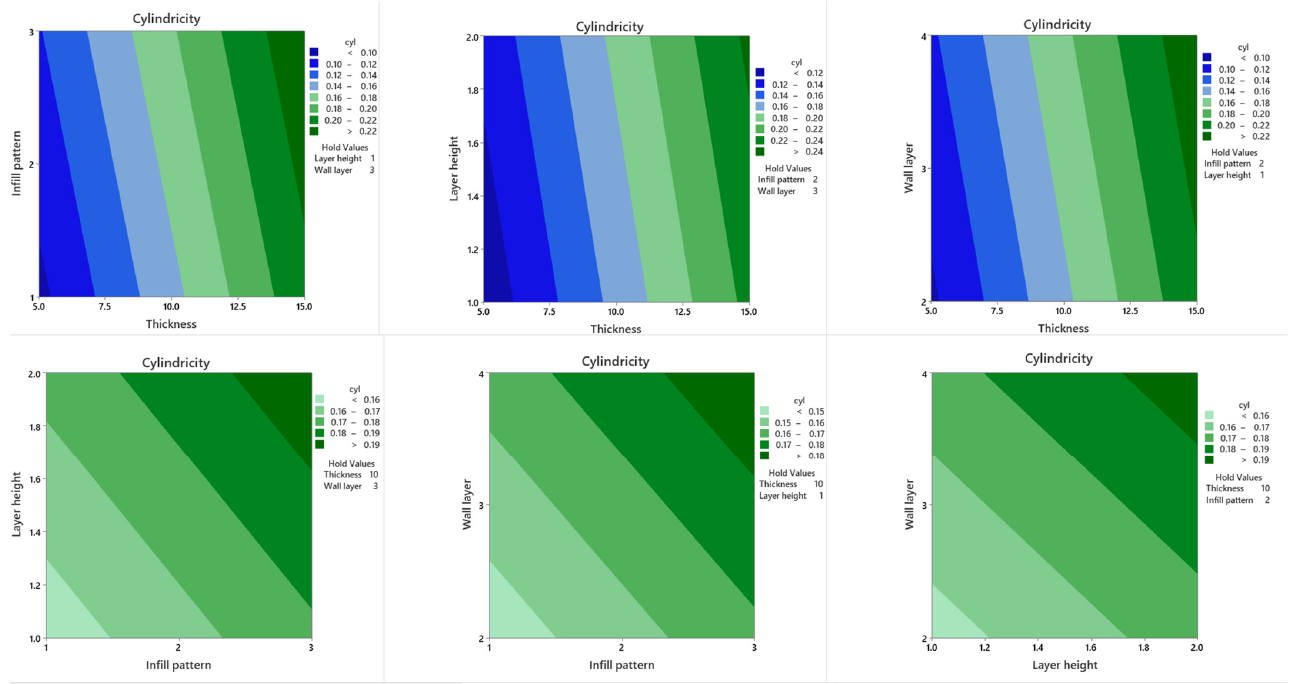
Figure 7. Cylindricity contour plots.